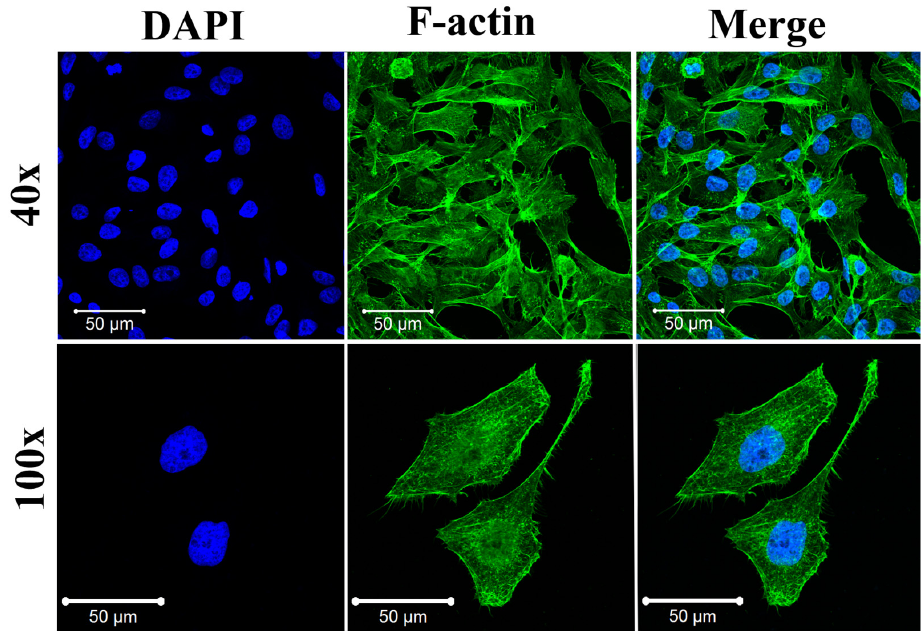
Figure 3. Immunofluorescent images of HUVEC cells cultured for 24 h on Lab-Tek. F-actin was stained by Alexa Fluor 488 Phalloidin (green) and cell nuclei were stained by DAPI (blue), respectively. Confocal laser scanning microscopes (CLSM) with a water immersion objective Zeiss 40×/NA 1.2 were applied.